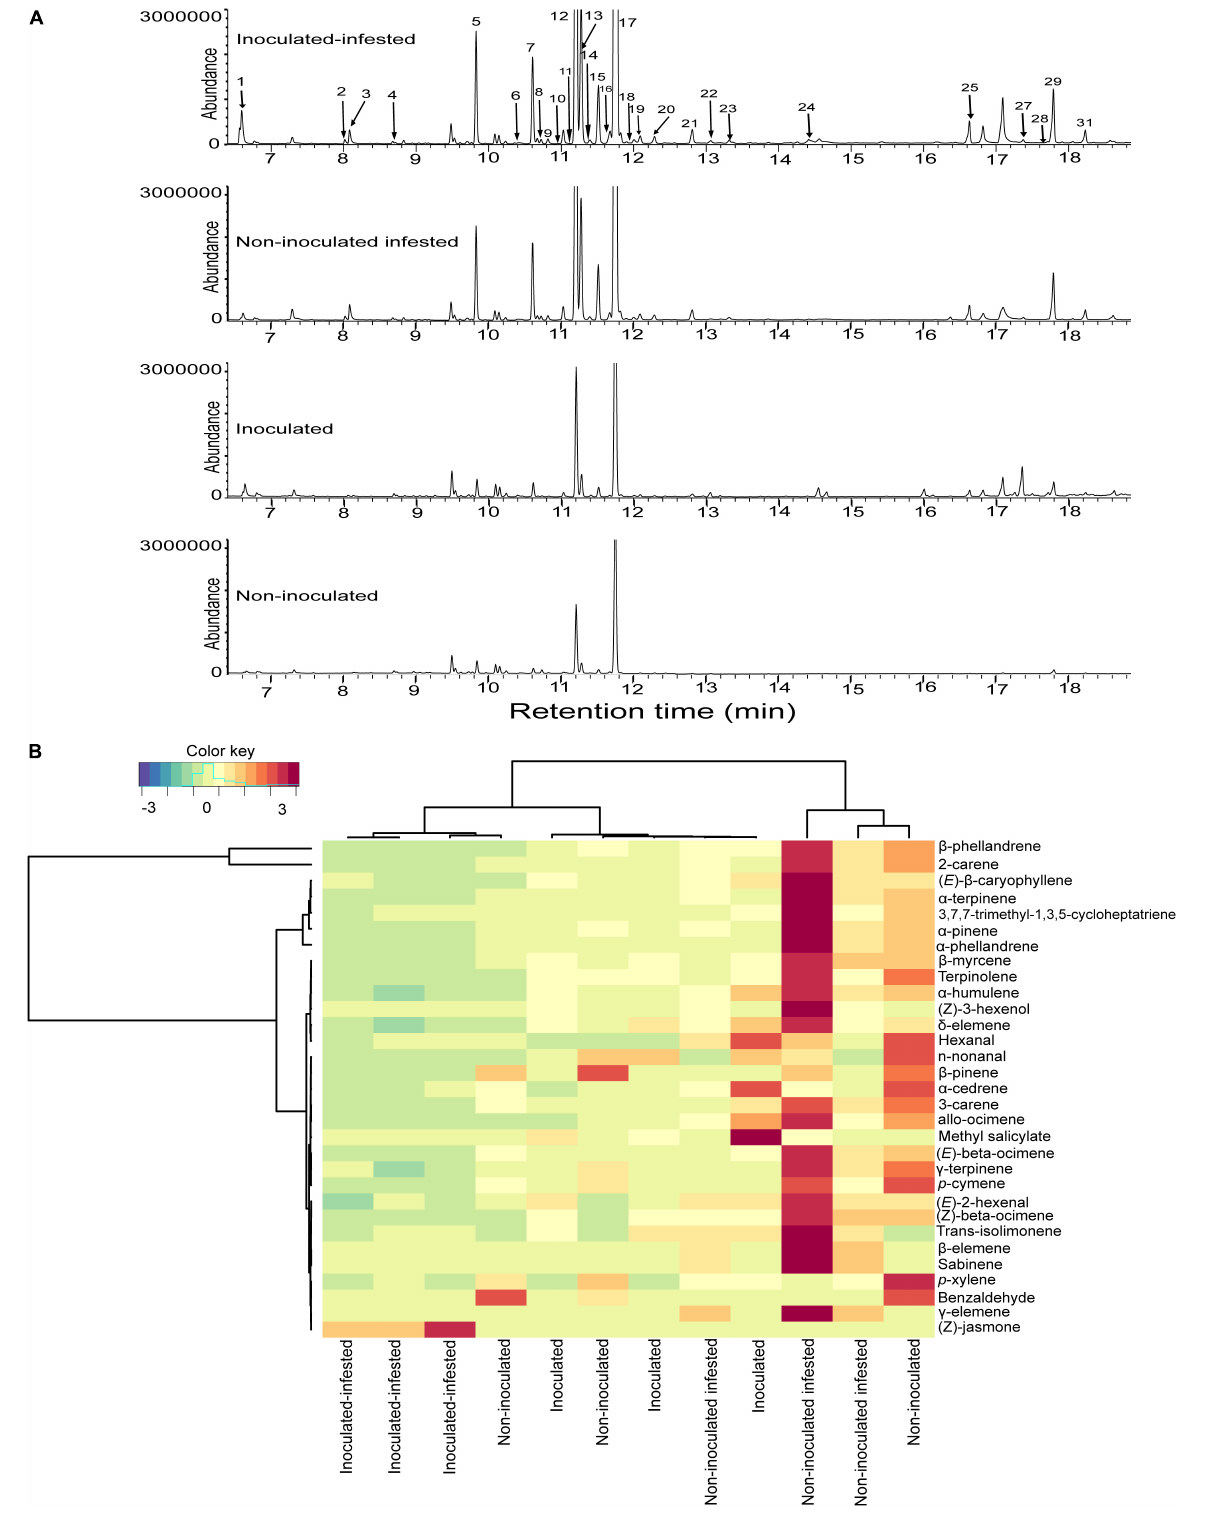
Frontiers in Plant Science |